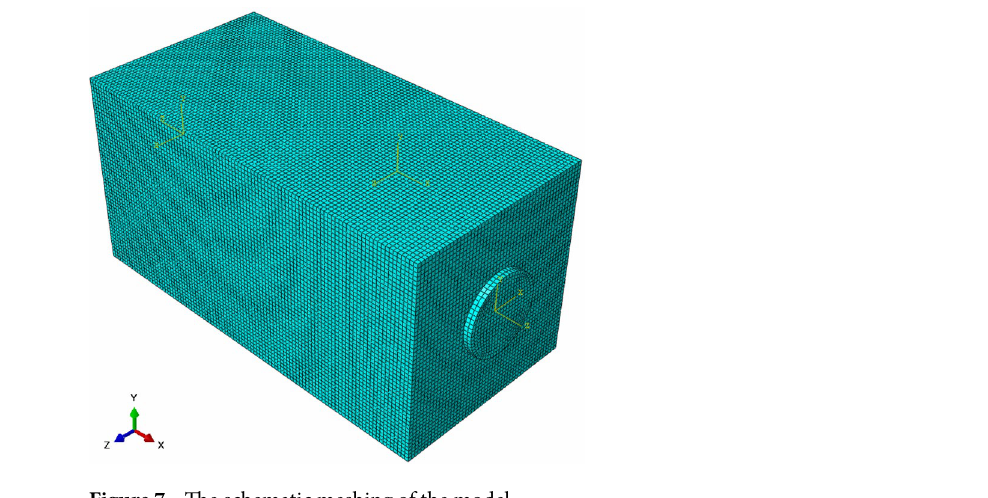
Figure 7. The schematic meshing of the model.